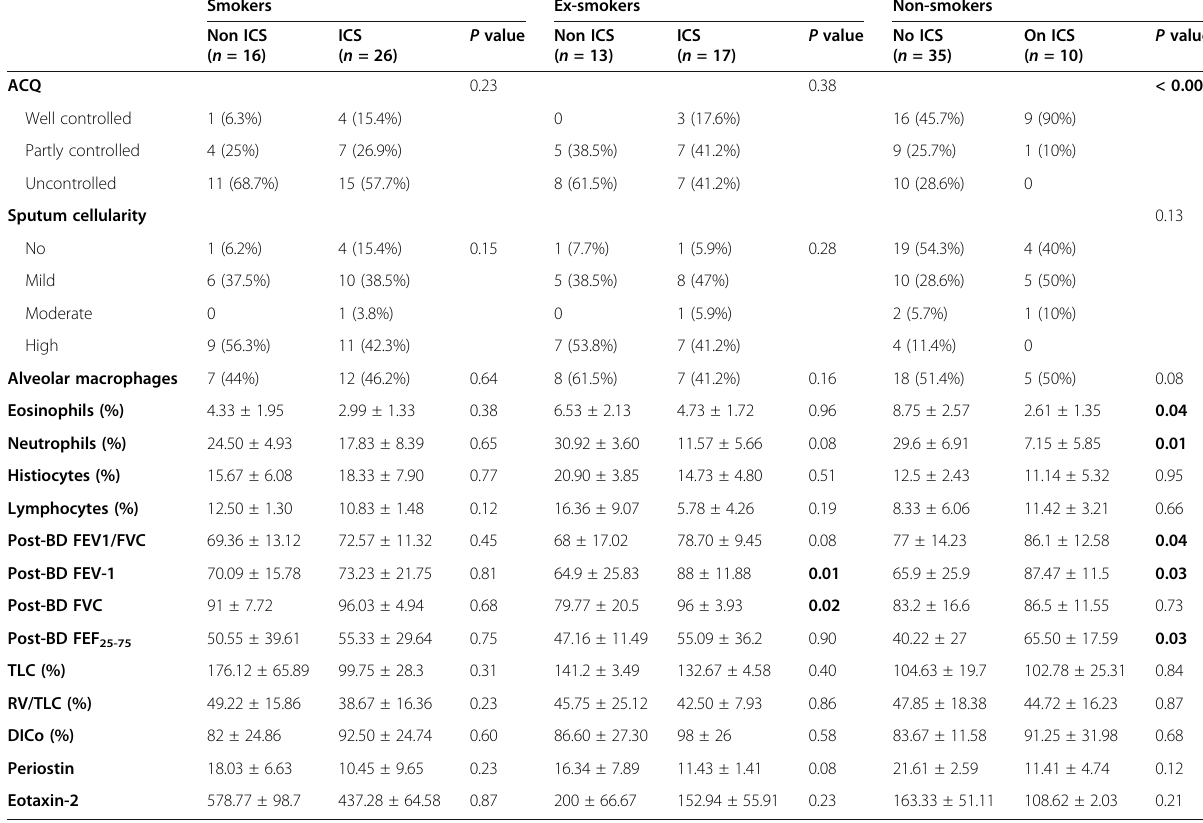
Table 3 Pulmonary function and sputum profile among studied groups based on ICS use